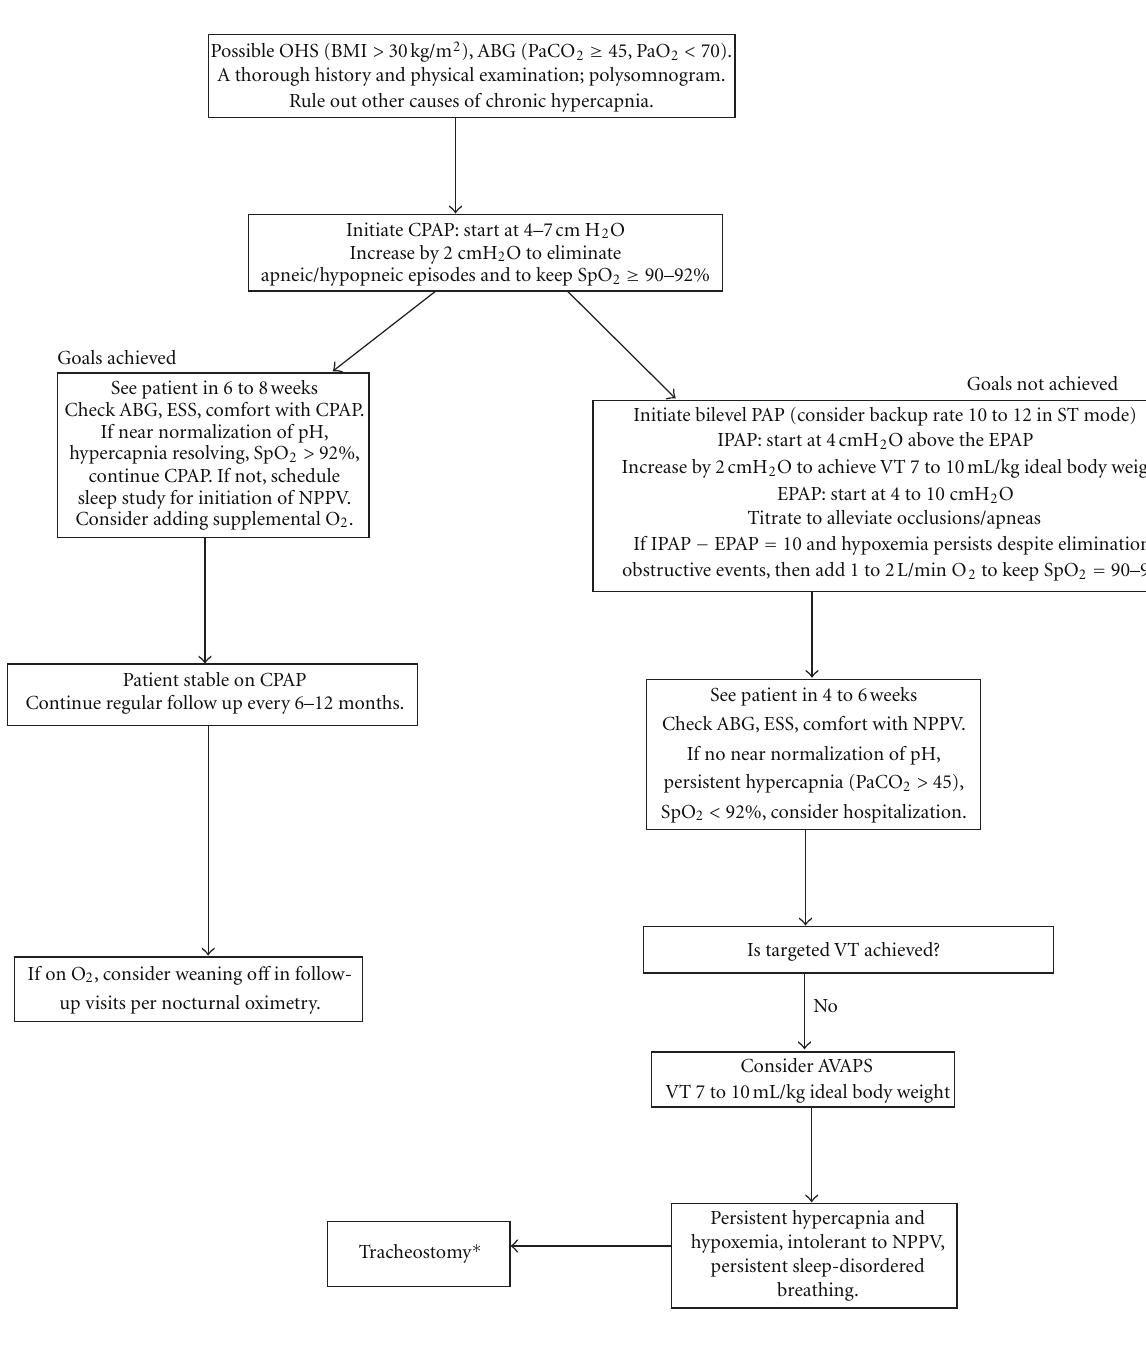
Figure 1: Our sleep lab’s approach to patients with OHS. ∗ As with positive pressure therapies, tracheostomy is not a cure—but rather a temporizing measure to reduce propensity for progressive cardiorespiratory failure until weight loss can be achieved. A consensus approach is presented in